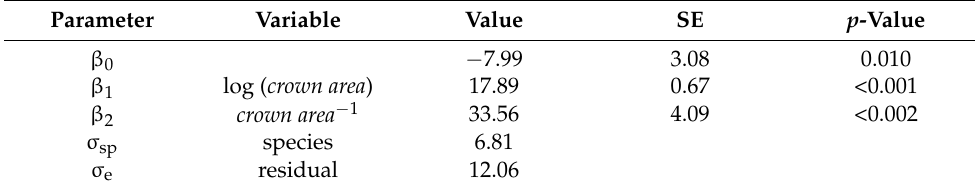
Table 3. Parameters of the mixed model for predicting individual-tree DBH based on remote sensing metrics. The coefficient of determination was R 2 = 0.55 for the fixed part of the model and R 2 = 0.66 when including between-species variability (standard deviation represented by σ ). The bias of the fixed part was − 2.28 cm (RMSE = 13.9).